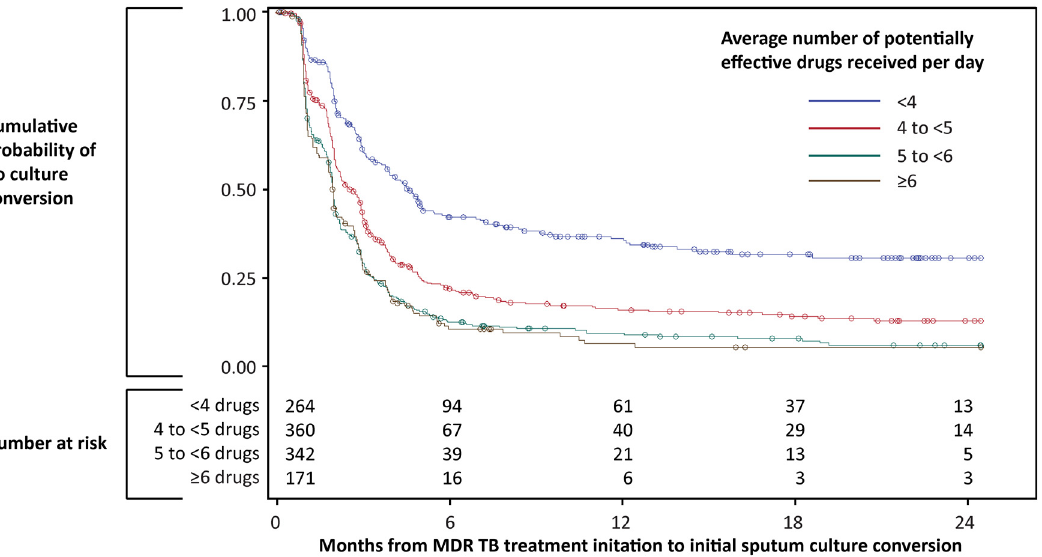
Fig 2. Time to initial sputum culture conversion by average number of potentially effective drugs received per day. Initial sputum culture conversion was defined as at least two consecutive negative cultures of sputum samples collected at least 30 d apart.